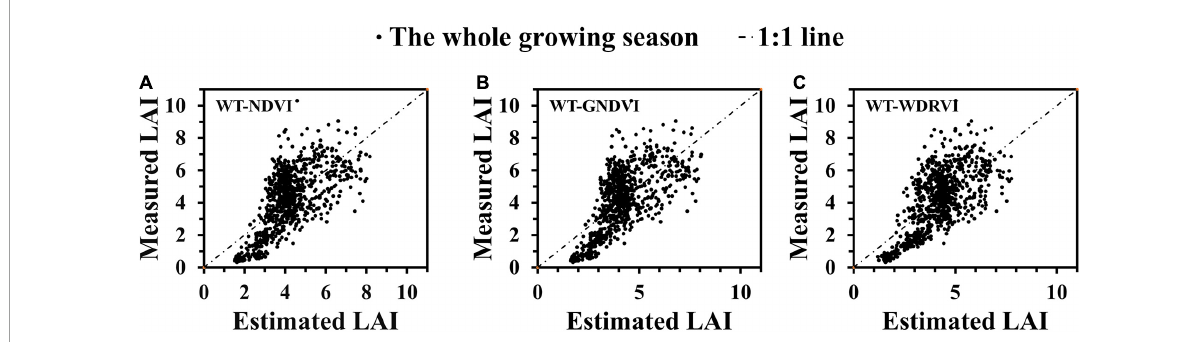
FIGURE7 Relationships between measured LAI and estimated LAI. (A) WT-NDVI. (B) WT-GNDVI. (C) WT-WDRVI.